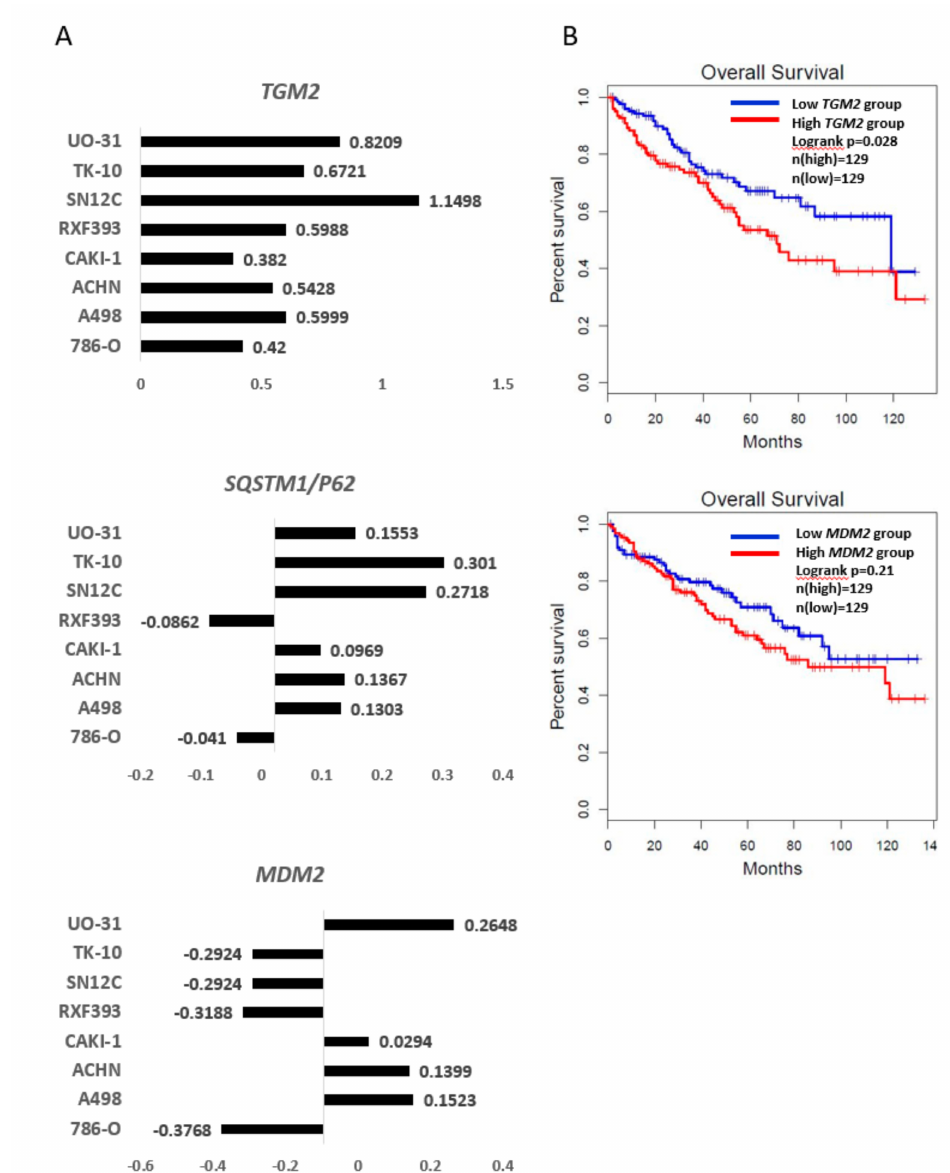
Figure 3. Expression of TGM2 , MDM2 , and SQSTM1 / p62 in RCC: ( A ) Microarray data from the U.S. National Cancer Institute (http: // dtp.nci.nih.gov / mtweb / targetdata). TGM2 (experiment ID: 9993; https: // dtp.cancer.gov / mtweb / targetinfo?moltid = GC19395&moltnbr = 9993) expression is consistently higher in RCC cell lines, whereas that of MDM2 (experiment ID: 3080; https: // dtp.cancer.gov / mtweb / targetinfo?moltid = GC12482&moltnbr = 3080) expression is not. Expression of SQSTM1 / P62 (experiment ID: 9233; https: // dtp.cancer.gov / mtweb / targetinfo?moltid = GC18635&moltnbr = 9233) is higher in most RCC cell lines. The graph is on a log scale (mRNA levels in cell line / mRNA levels in a reference pool). Reference probes were made by pooling equal amounts of mRNA from the HL-60, K562, NCI-H226, COLO205, SNB-19, LOX-IMVI, OVCAR-3, OVCAR-4, CAKI-1, PC-3, MCF7, and Hs578T cell lines. The average mRNA levels of TGM2, SQSTM1 / P62 , and MDM2 are 0.05, − 0.05, and − 0.09, respectively. ( B ) Kaplan–Meier survival curves based on expression of TGM2 or MDM2 : Patients with high expressions of TGM 2 show shorter overall survival than those with low expression ( p = 0.028). The overall survival of MDM2 is not significant ( p =